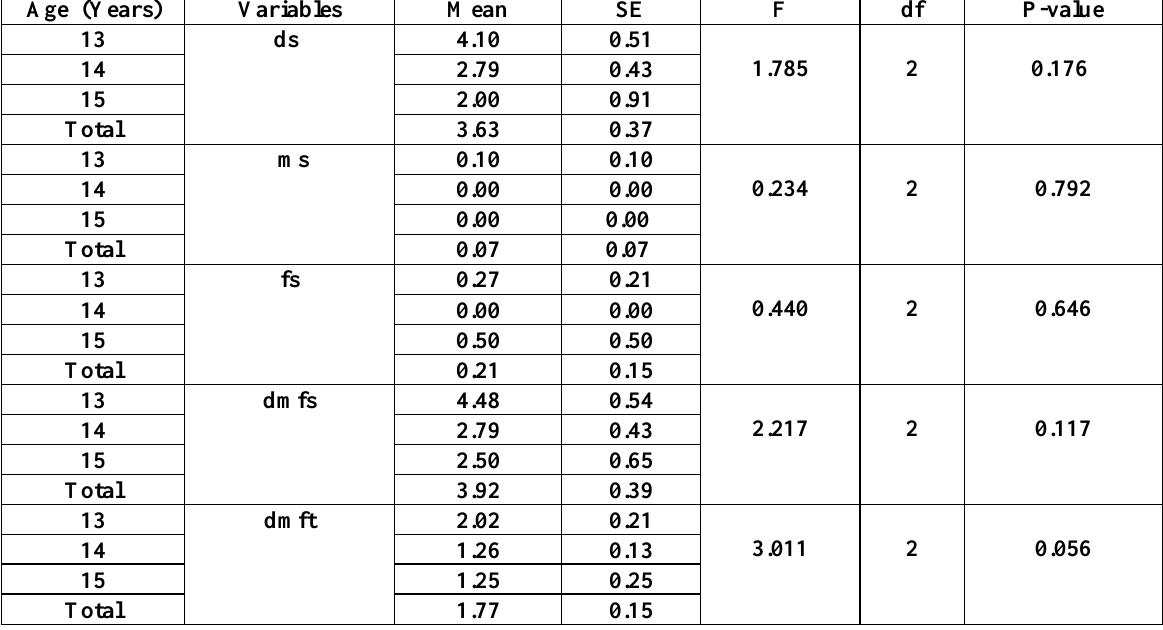
Table 5: Caries experience of the primary teeth (mean and standard errors) among students by age.